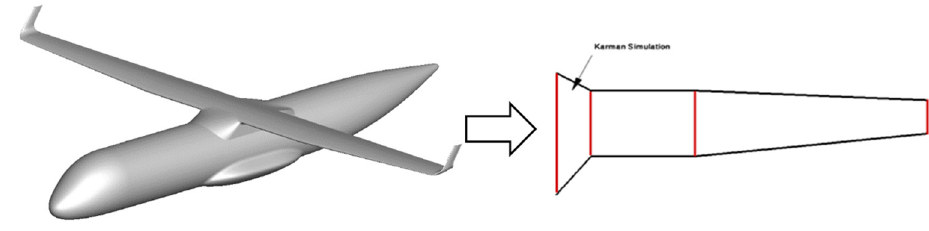
Figure 27. AG2-NLF configuration—data used by the aerodynamic module (4 wing sections).